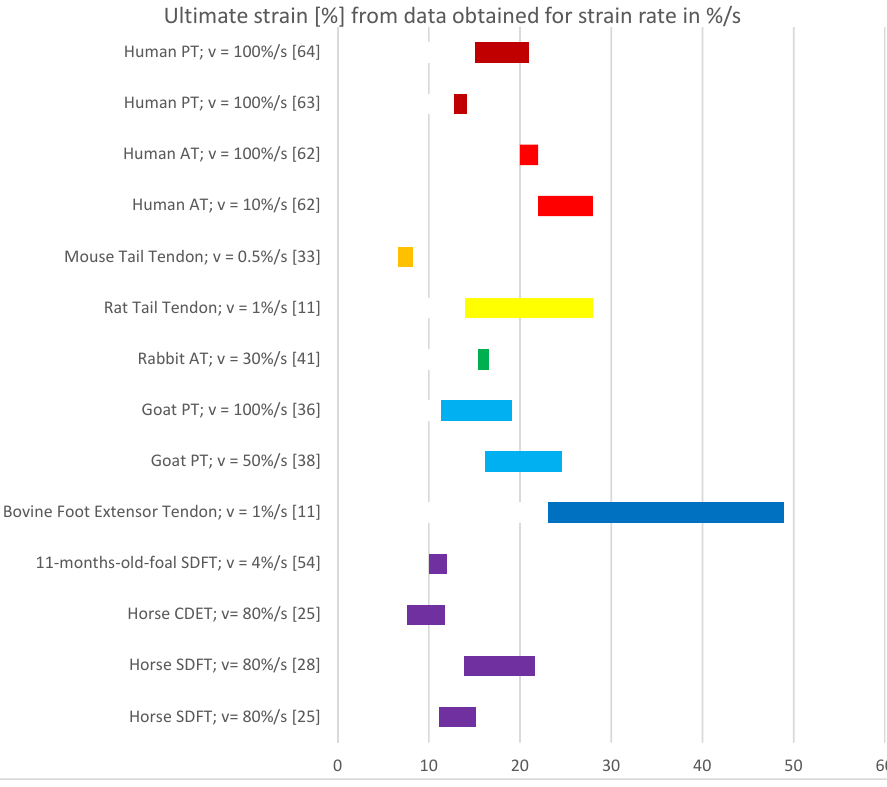
Figure 7. Ultimate strain for the considered animal species (%/s).